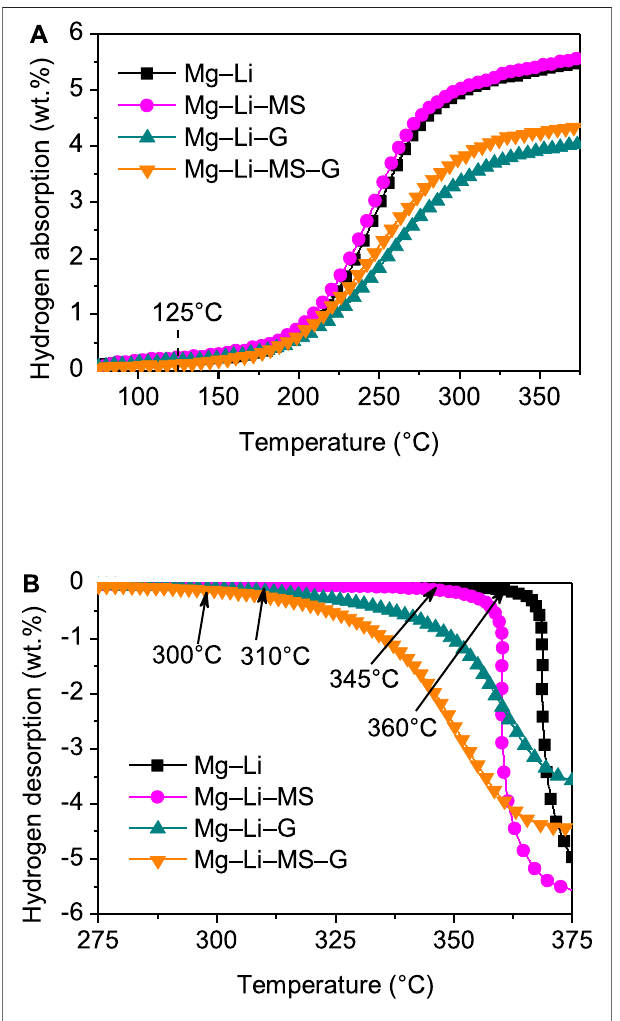
FIGURE 3 | Hydrogenation (A) and dehydrogenation (B) curves of the Mg − Li, Mg − Li − MS, Mg − Li − G, and Mg − Li − MS − G composites with a heating rate of 2 ° C min − 1 .